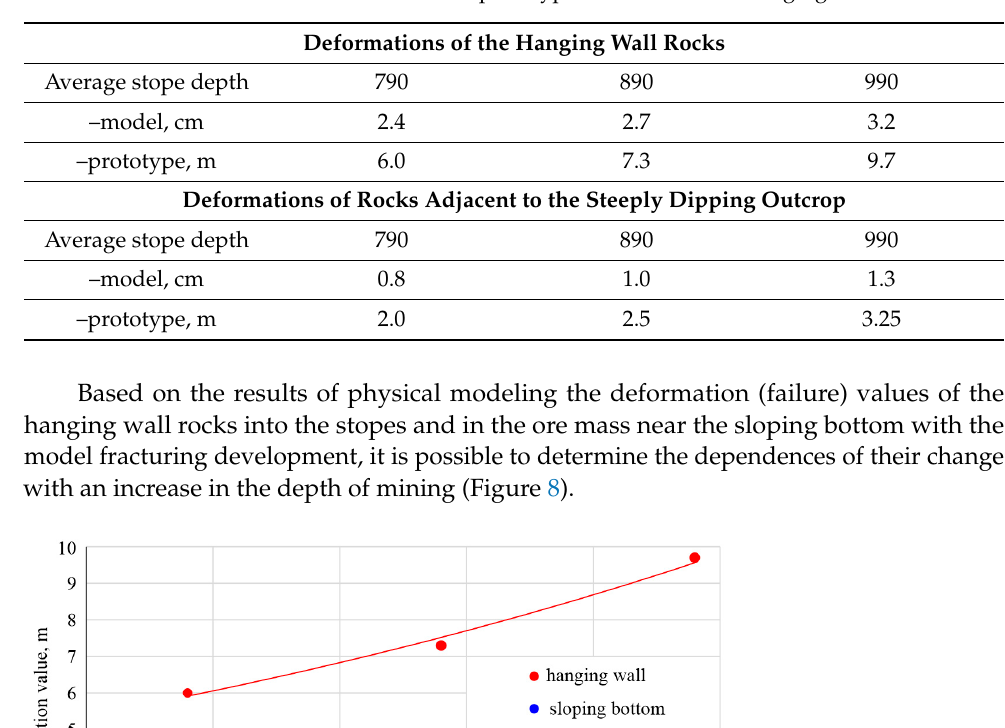
Table 2. Results of the research on model and prototype deformations in hanging wall.